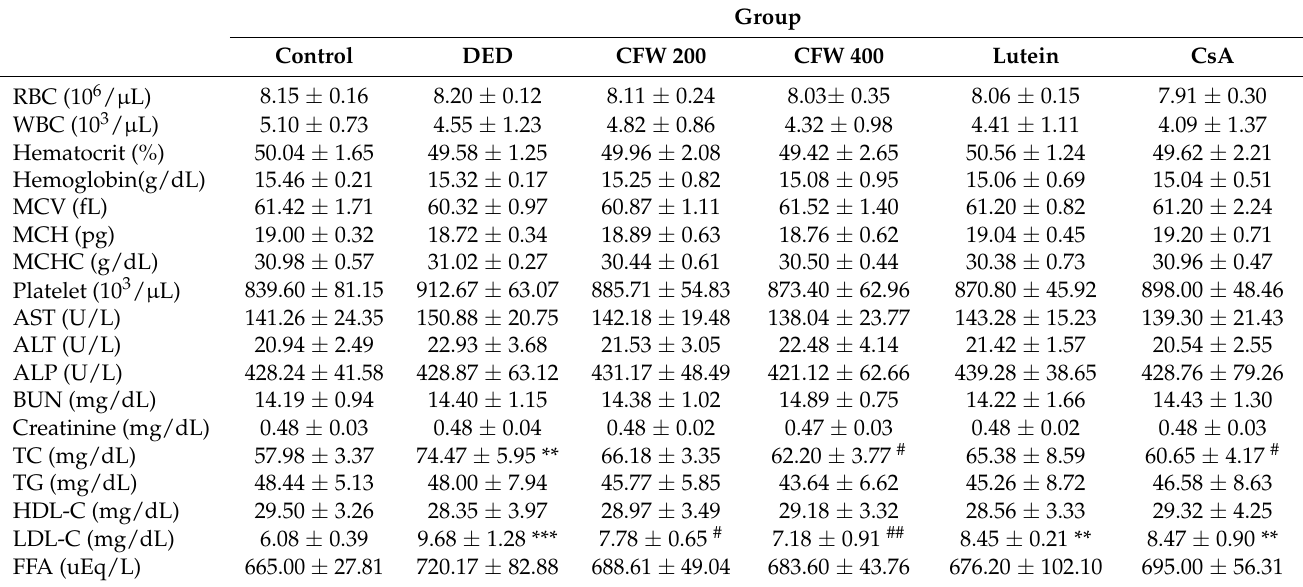
Table 2. Effect of oral administration of CFW on the hematological, biochemical, and lipid profiles in SD rats after topical exposure to PM 2.5 .